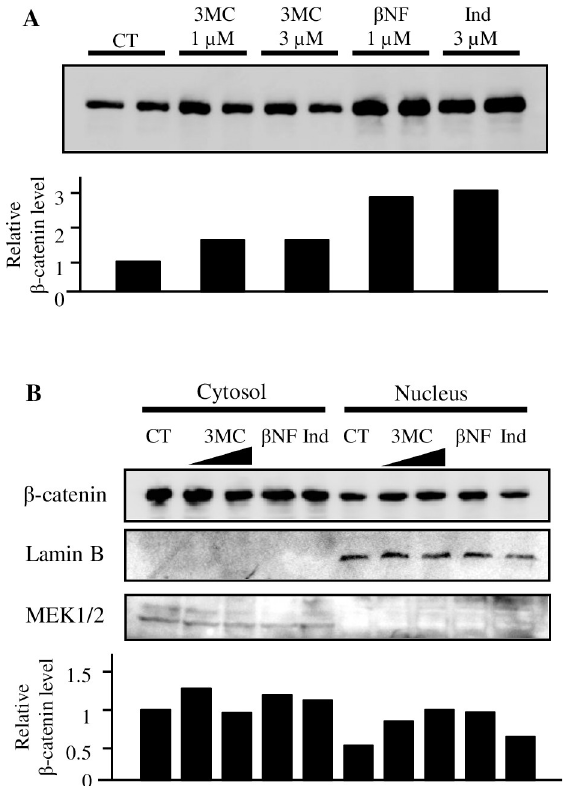
Fig 1. Change in β -catenin levels due to AhR ligand exposure in DLD-1 cells. A ) DLD-1 cells were exposed to 3-methylcholanthrene (3MC; 1 or 3 µ M), β -naphthoflavone ( β NF; 1 µ M), or indirubin (Ind; 3 µ M) for 6 h. As a solvent control, 0.1% DMSO was added to cells (CT). Cytoplasmic proteins were extracted and 10 µ g protein were subjected to western blotting with β -catenin antibodies. Individual band was quantitated in ImageQuant. Lower panel shows relative amount of β -catenin expression. Each bar represents the mean of duplicate determinations. B ) Nuclear and cytoplasmic proteins were extracted from DLD-1 cells after 3MC (from left to right, 1 or 3 µ M), β NF (1 µ M), or Ind (3 µ M) exposure for 6 h. Anti-Lamin B and anti-MEK1/2 antibodies were used in the samples. Lower panel shows relative amount of β -catenin expression compared to control (cytosol). Each bar represents the mean of duplicate